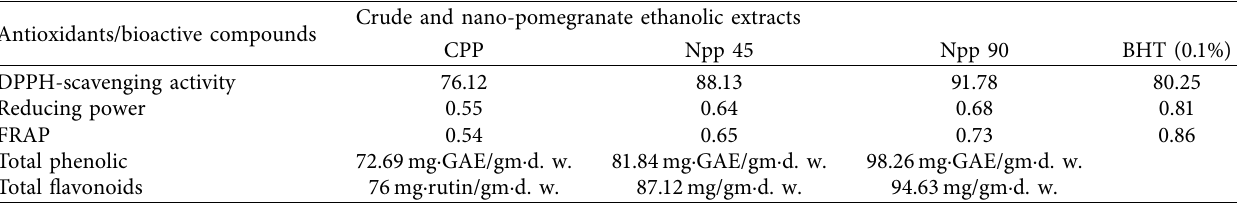
Table 1: Oxygen scavenging activity, reducing power, and ferric reducing antioxidant power of ethanolic extract of nano-pomegranate peel ethanolic extract.